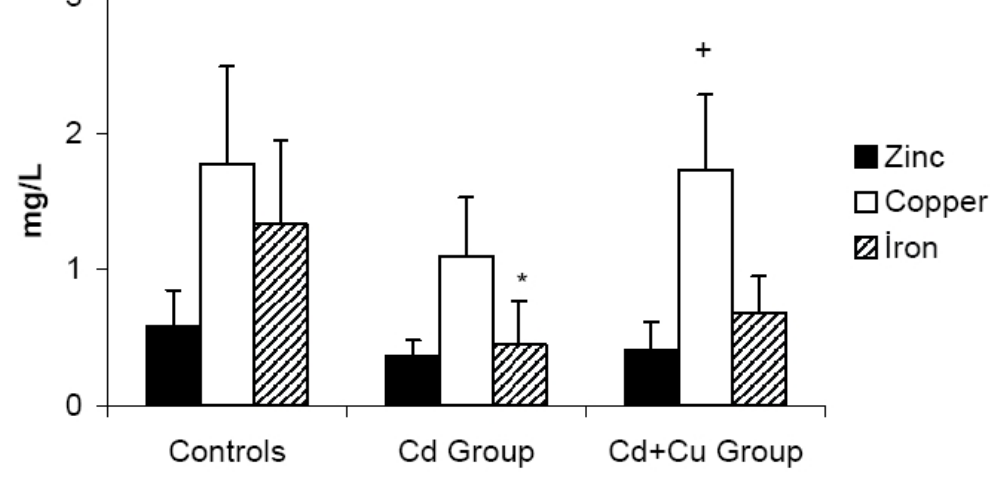
Fig. 2 Plasma Cu, Zn, and Fe levels. *P < 0.05 between controls and Cd or Cd+Cu groups. +P < 0.05 between Cd and Cd+Cu